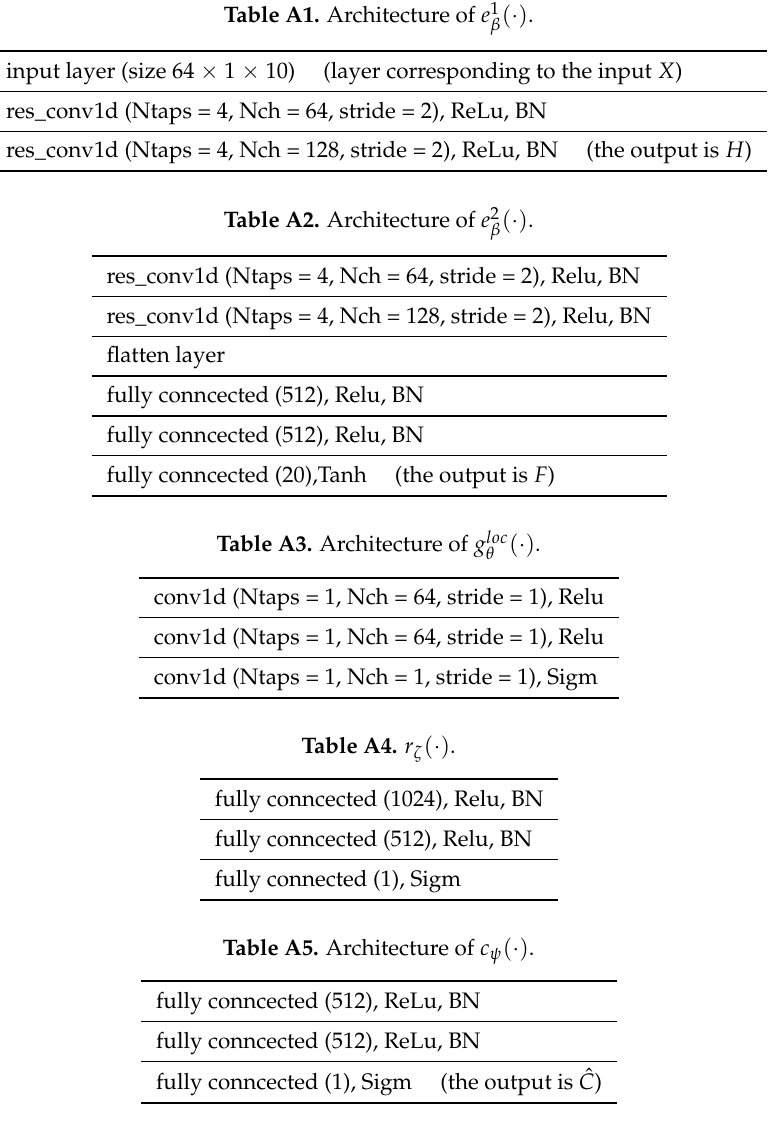
Table A1. Architecture of e 1